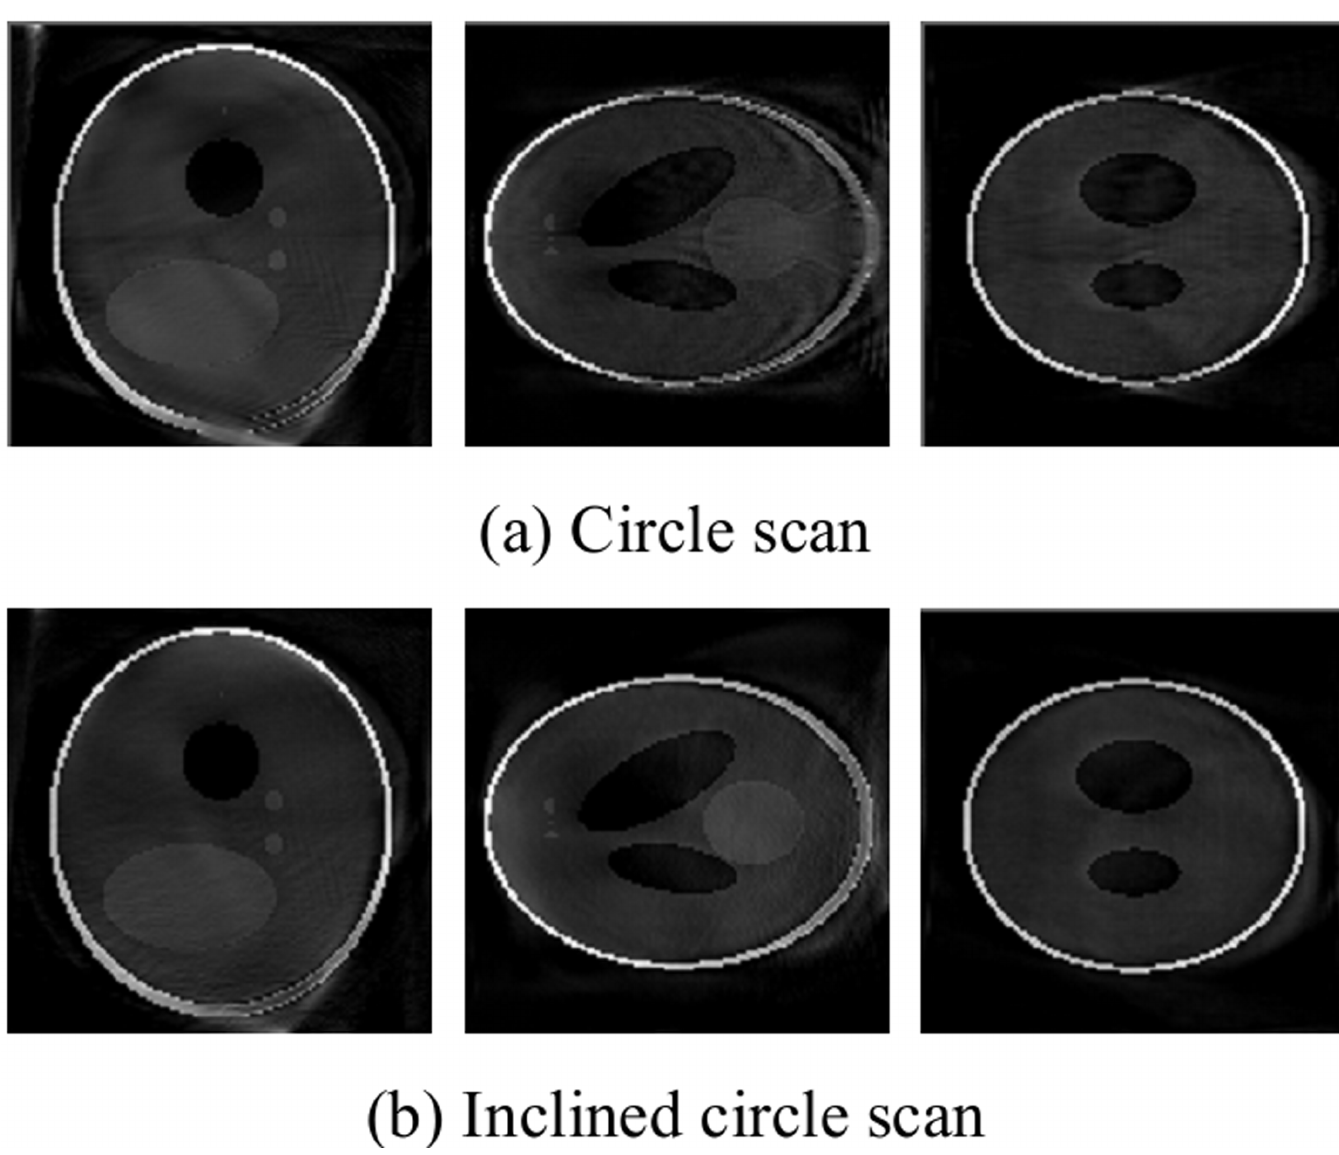
Fig 6. Slices of reconstruction image with limited